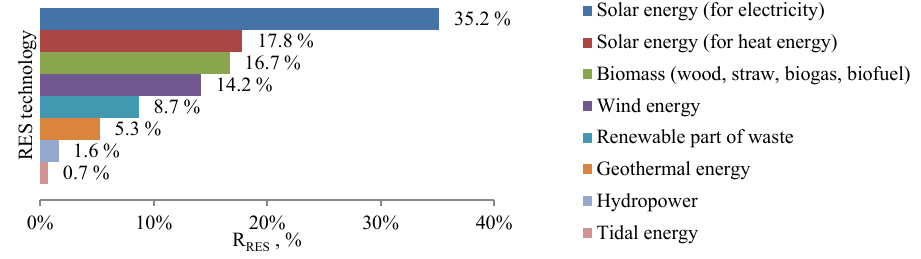
Fig. 1. Ranking of RES technologies according to enterprise survey